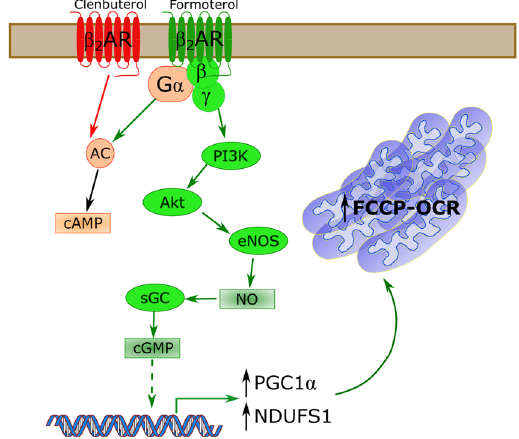
Figure 7. Formoterol, but not clenbuterol, induces MB in a G βγ -Akt-NOS-sGC-dependent manner despite increased cAMP accumulation. Both formoterol and clenbuterol activate G α s -dependent signaling to activate adenylate cyclase (AC) and promote cAMP accumulation. However, only formoterol activates the G βγ -PI3K- Akt-eNOS-sGC pathway, and it is this pathway that is necessary for β 2 AR-induced MB in